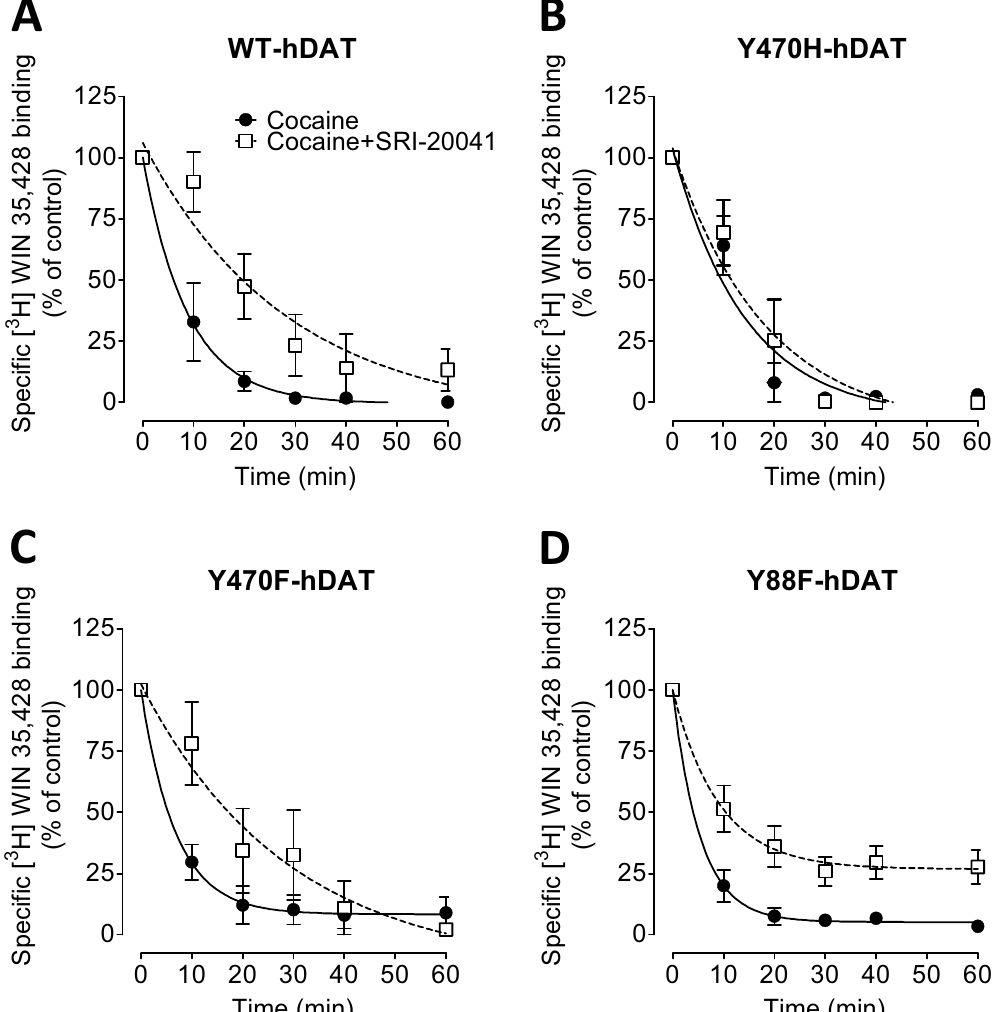
Figure 2. Effects of SRI-20041 and cocaine on the dissociation of [ 3 H]WIN 35,428 in WT hDAT and mutants. PC12 cells transfected with WT hDAT ( A ) or Y470H-hDAT ( B ), Y470F-hDAT ( C ), and Y88F-hDAT ( D ) were incubated with [ 3 H]WIN 35,428 (final concentration, 5 nM) on ice for 2 h. After the 2 h incubation, the incubation reagent was replaced with fresh assay buffer. At the zero time point, cocaine (1 µ M) was added to Condition-1 and Condition-2 (also see Table 3). Ten minutes later, SRI-20041 (10 µ M) was added to Condition-2. Cells were lysed at indicated time points. For the data analysis, the 100% control point (no drug) was time 0 for Condition-1 and time 10 min point for Condition-2. Each data point is the mean ± S.E.M. ( n = 5–8).